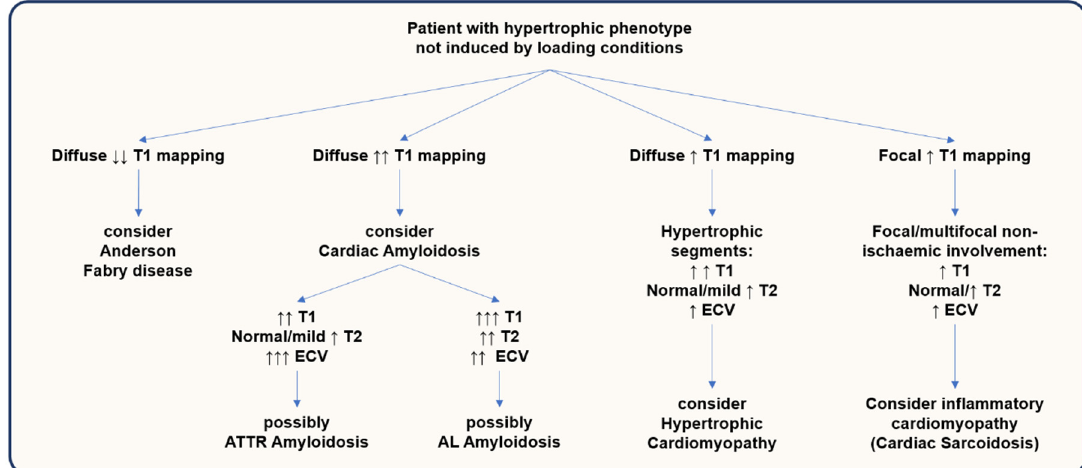
Figure 7. Etiological hypotheses of newly diagnosed myocardial hypertrophy according to mapping abnormalities. When informative data provided by mapping sequences are integrated to those delivered by clinical history, cardiovascular magnetic resonance (CMR) morphological analysis and, when possible, LGE assessment, differential diagnoses of Hypertrophic Cardiomyopathy, Cardiac Amyloidosis, Fabry disease or inflammatory cardiomyopathy such as Cardiac Sarcoidosis could be established with the highest degree of confidence.